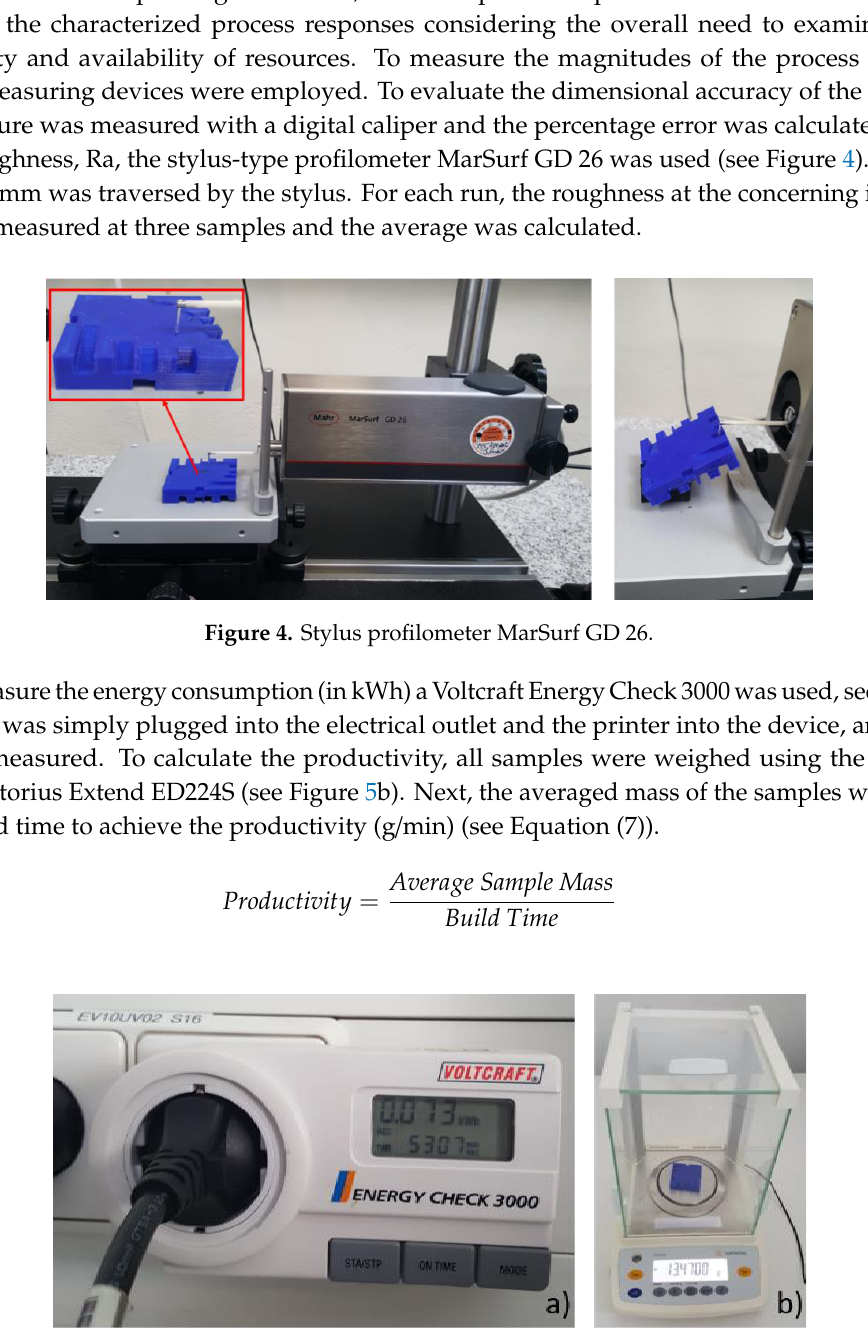
Figure 5. ( a ) Energy measuring device Voltcraft Energy Check 3000 and ( b ) analytical balance Sartorius Extend ED224S.